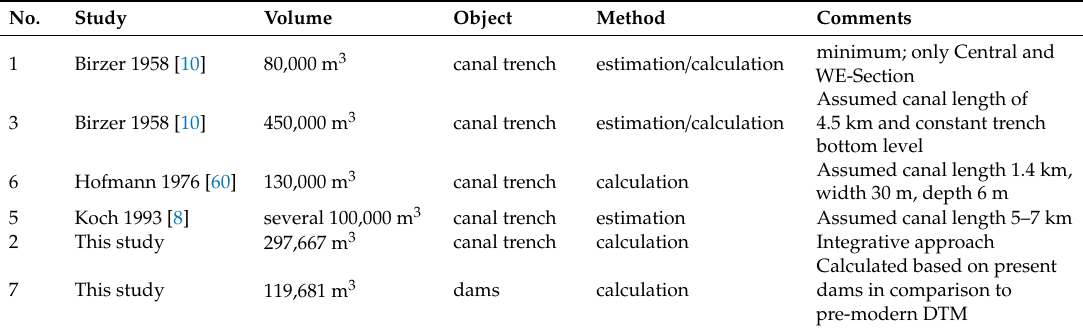
Table 3. Scientific history of Fossa Carolina volume